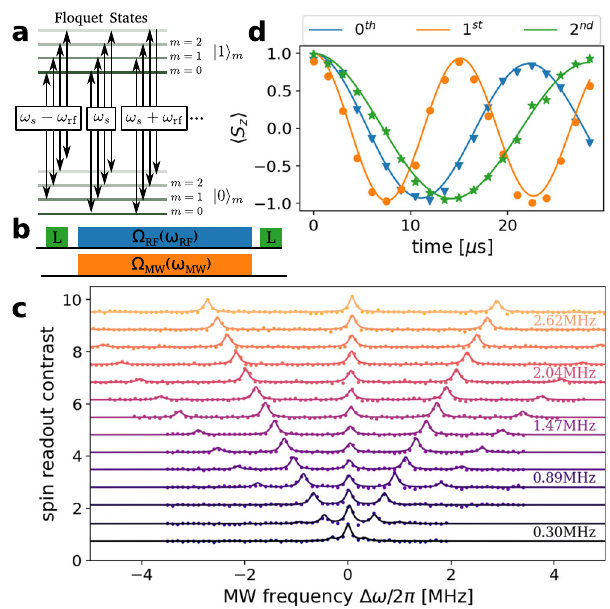
Fig. 4 MW detection with a longitudinal RF dressing. a The RF driving creates the new energy states E 0, m = m ω rf and E 1, m = ω s + m ω rf . Generating sidebands with ω = ω s + Δ m ω rf . b Experimental scheme for probing these transitions. Initialization and readout with green laser pulses, followed by simultaneous RF (blue) and MW (orange) driving. c Optically detected magnetic resonance spectrum with varied ω rf showing the Floquet sidebands at multiples of ω rf . d Rabi oscillations at the central peak (0th), fi rst, and second sideband. The amplitude of RF is chosen such that the Rabi frequency is largest for the fi rst sideband and is described with ν ¼ J ð 2 : 5MHz Þ (cid:3) 0 : n Rabi ; n 1 : 45MHz